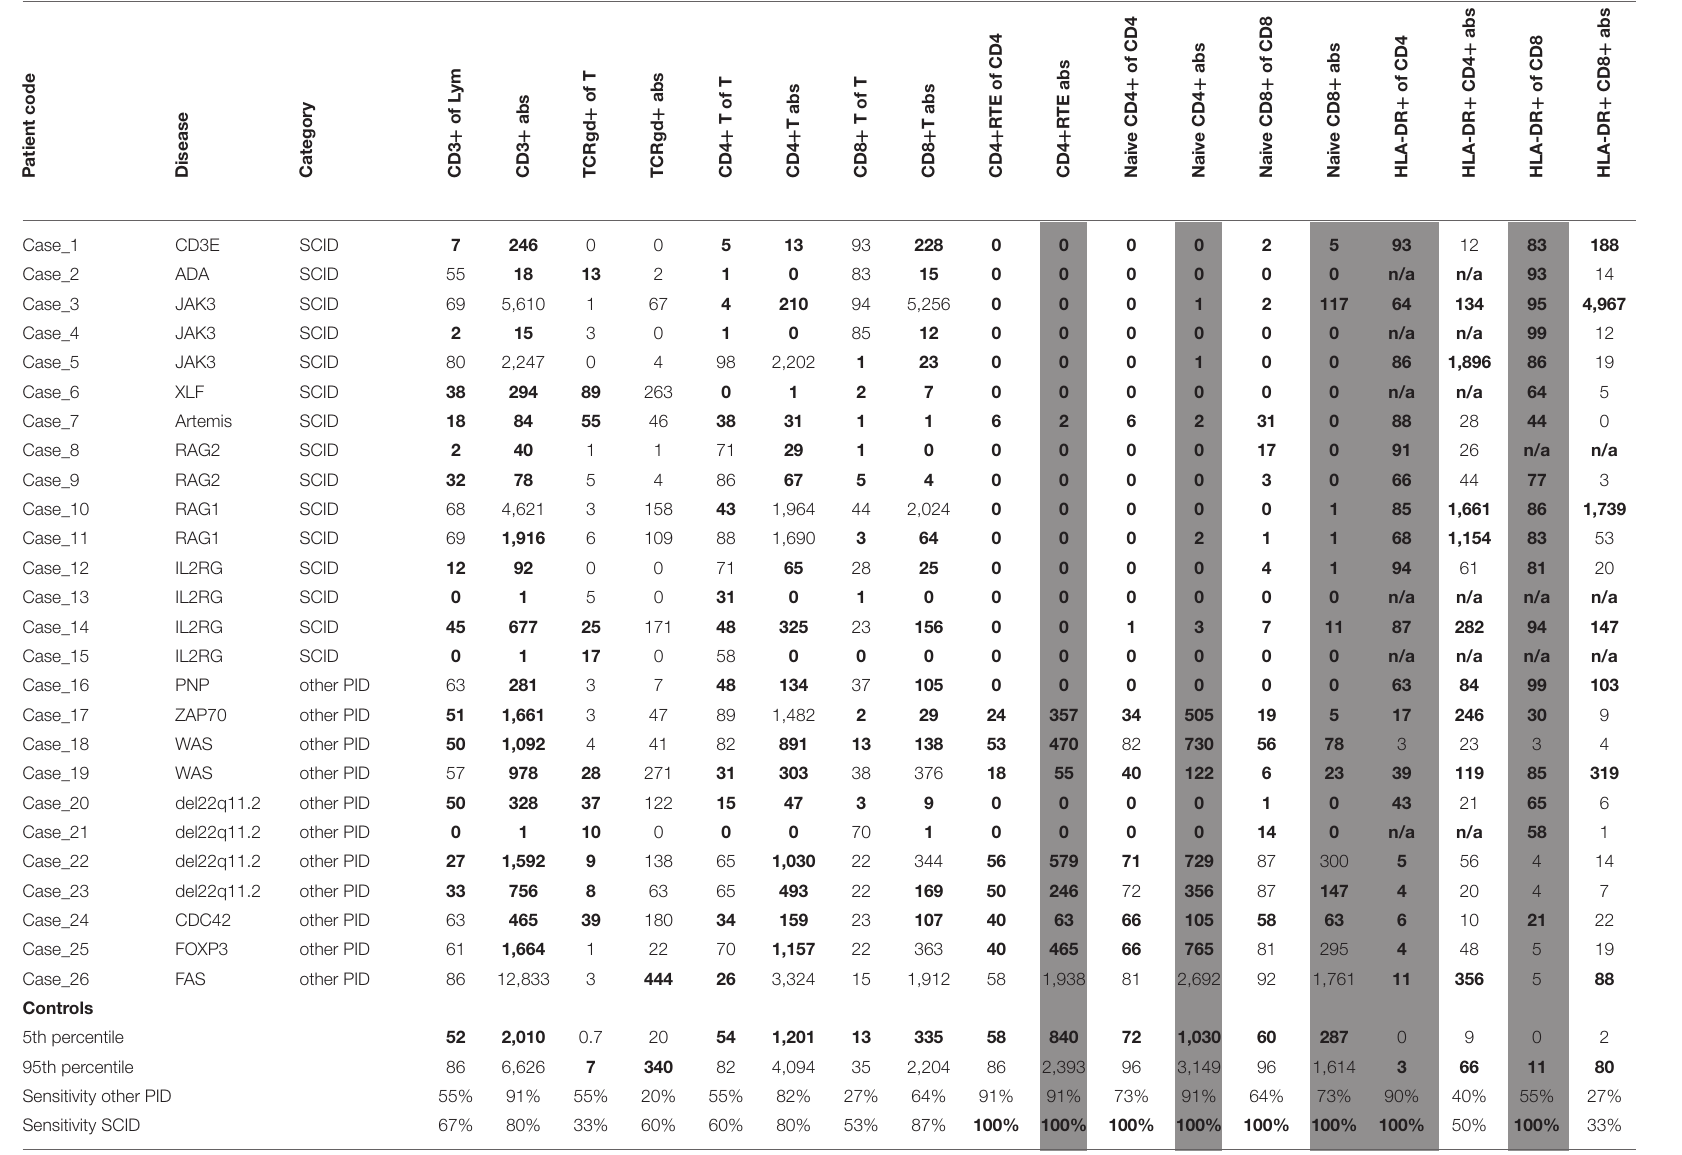
TABLE 3 | Lymphocytes subsets evaluated by SCID-RTE